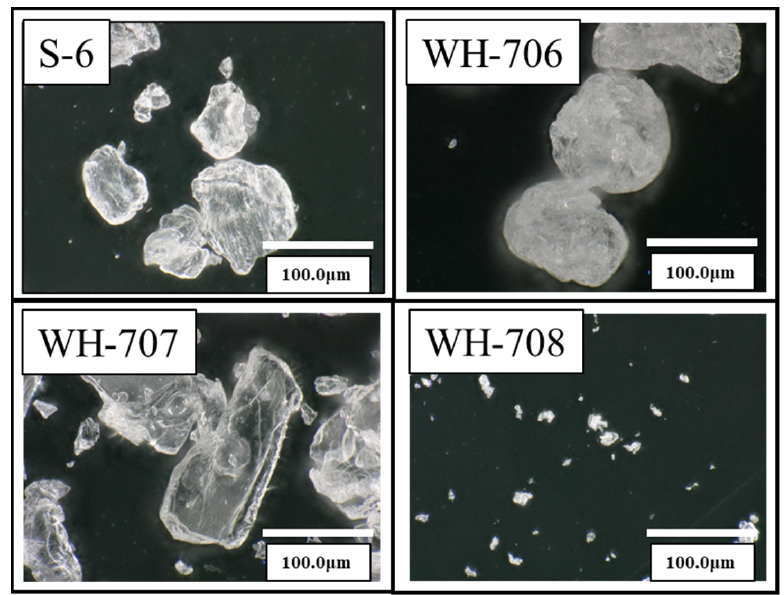
Figure 3. SEM images of agar particle are shown. S-6 is powdery and has an average diameter of 102 µm, WH-706 is spherical and has an average diameter of 87 µm, WH-707 is scaly and has an 102 µ m, WH-706 is spherical and has an average diameter of 87 µ m, WH-707 is scaly and has an average diameter of 105 µm, and WH-708 is a fine powder and has an average diameter of 8 µm. average diameter of 105 µ m, and WH-708 is a fine powder and has an average diameter of 8 µ